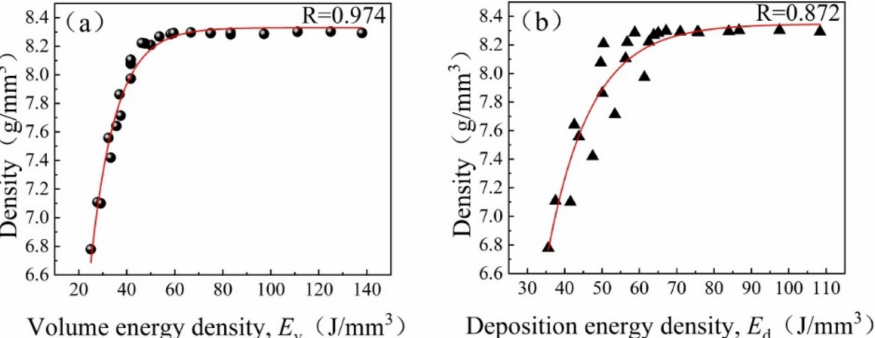
Figure 6. Change in the density of LBPBF GTD222 alloy as a function of the ( a ) volume energy density and ( b ) deposition energy